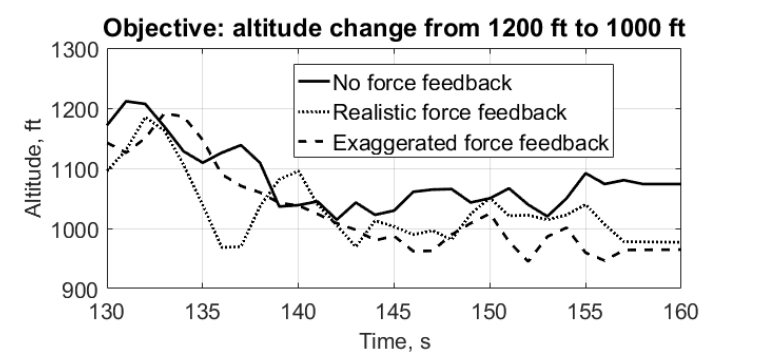
Figure 12. Altitude analysis at 1200 ft.